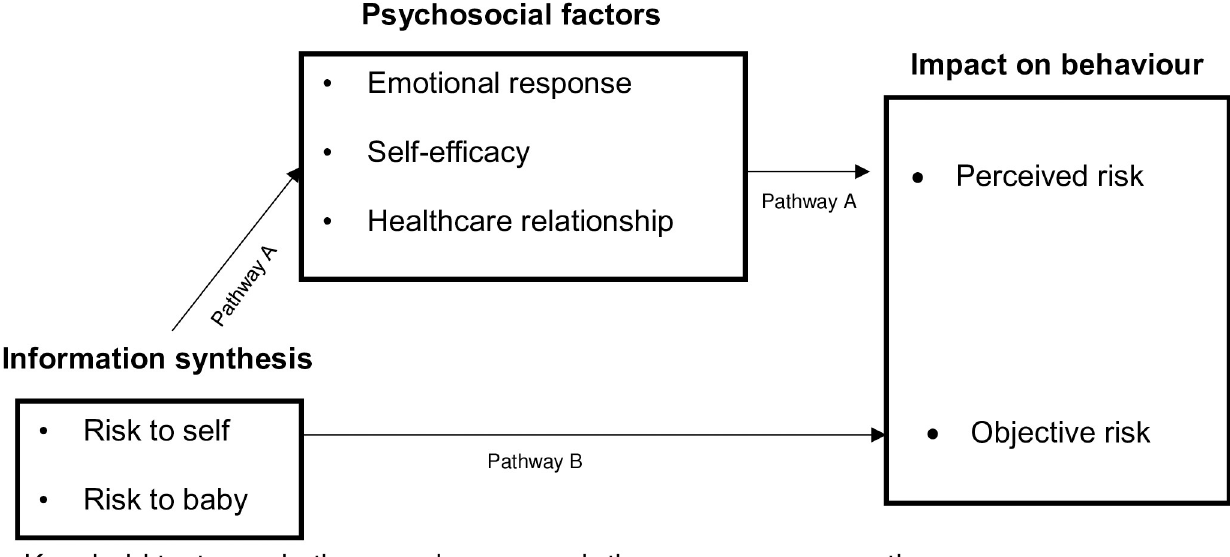
Fig 2. Proposed pathway of